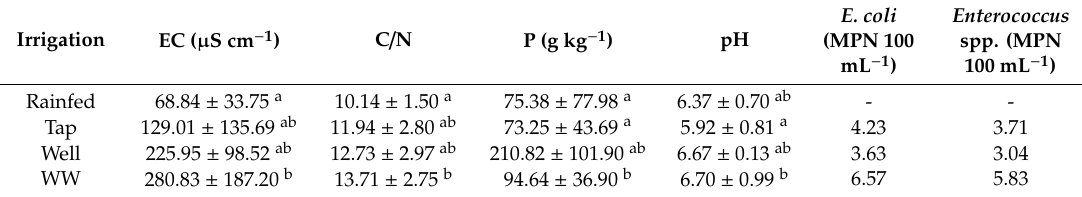
Table 1. Mean ± standard deviation of soil carbon-to-nitrogen ratio (C / N), electrical conductivity (EC), total phosphorous (P), pH, and counts of Escherichia coli and Enterococcus spp. (in most probable number (MPN) 100 mL − 1 ) within the irrigation water source measured in vegetable fields under di ff erent irrigation sources in four urban and peri-urban agriculture (UPA) locations in Tamale,